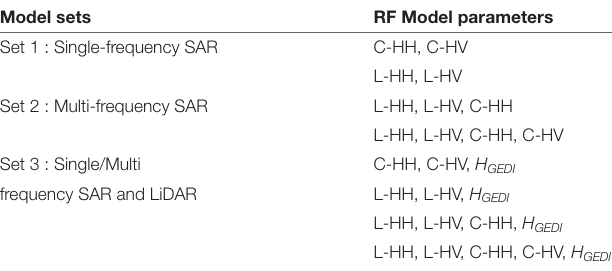
TABLE 3 | Predictor variables used in the Random forest regression algorithm for forest aboveground biomass estimation in Shivamogga forest. H GEDI represents the canopy height obtained from GEDI L2A